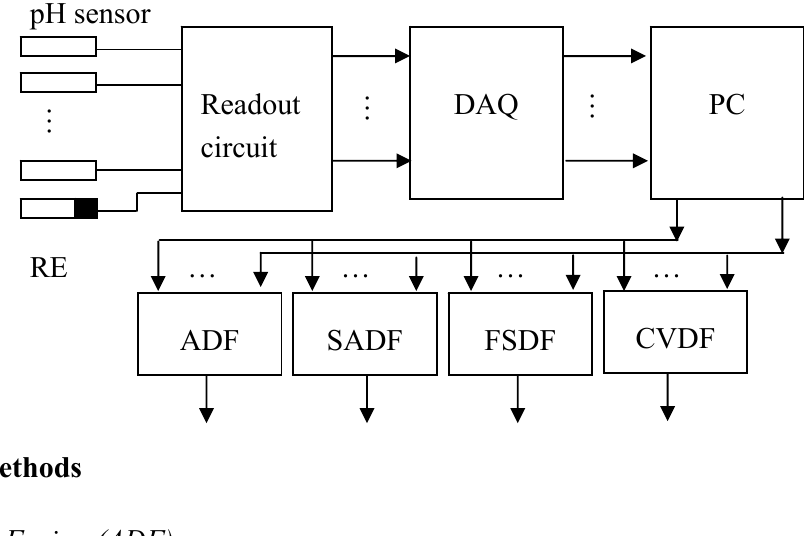
Figure 1. Experimental structure includes a sensor array with eight pH sensors, a reference electrode, readout circuit and uses a data acquisition card connected to a personal computer, and the measured data used for data fusion with different data fusion